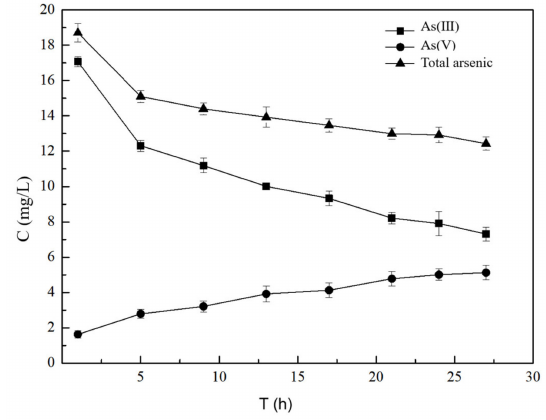
Figure 4. Concentration changes of arsenic in MFC-As.